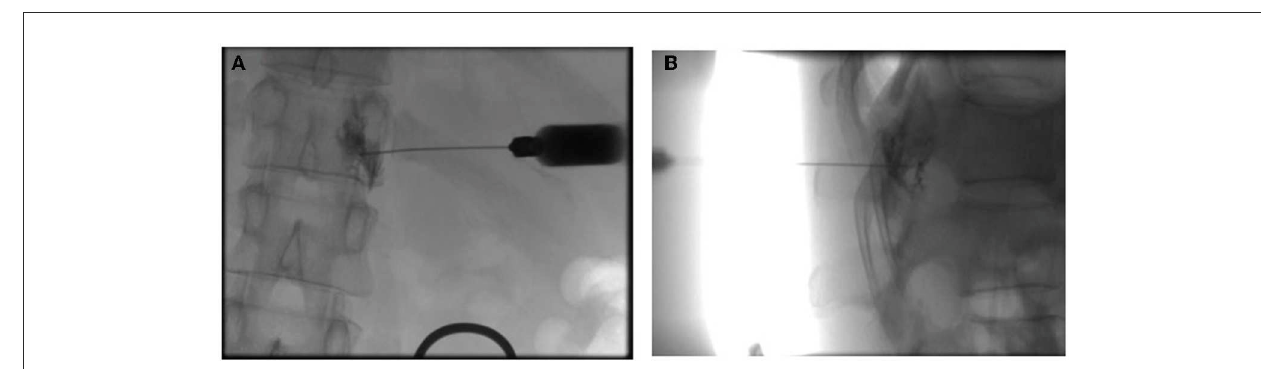
FIGURE2 Confirmation of the extent of the block with contrast under the C-arm X-ray machine positioning. (A) Anteroposterior film showing the needle tip’s position at the connecting line of the intervertebral foramen on the affected side and the entry of the contrast agent into the spinal canal along the nerve root. (B) Lateral film of the upper half of the intervertebral foramen on the affected